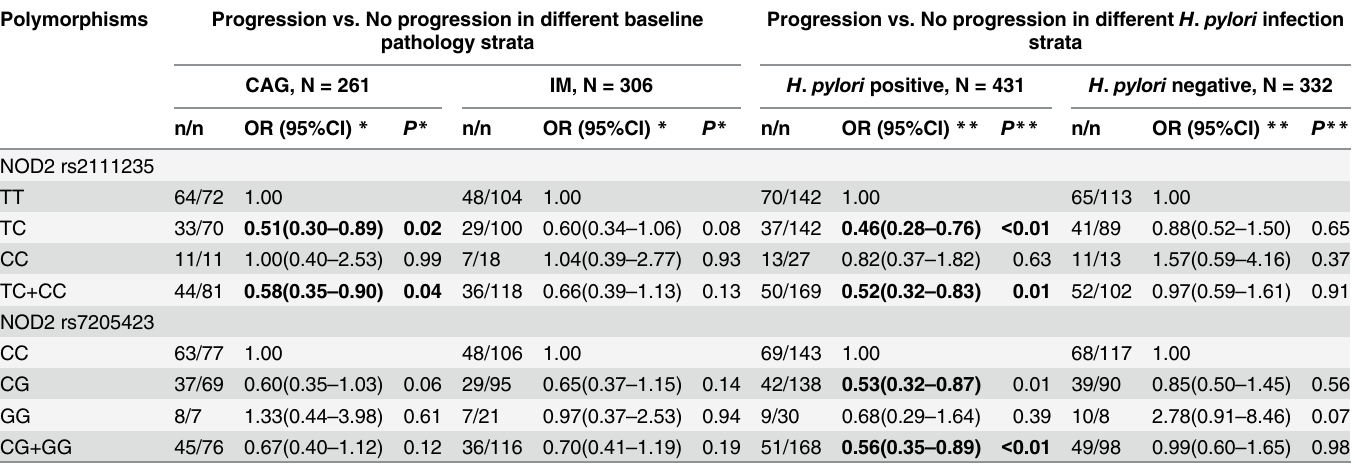
Table 5. Risk of progression of gastric lesions associated with polymorphisms stratified by baseline pathology or H . pylori infection status. Polymorphisms Progression vs. No progression in different baseline pathology